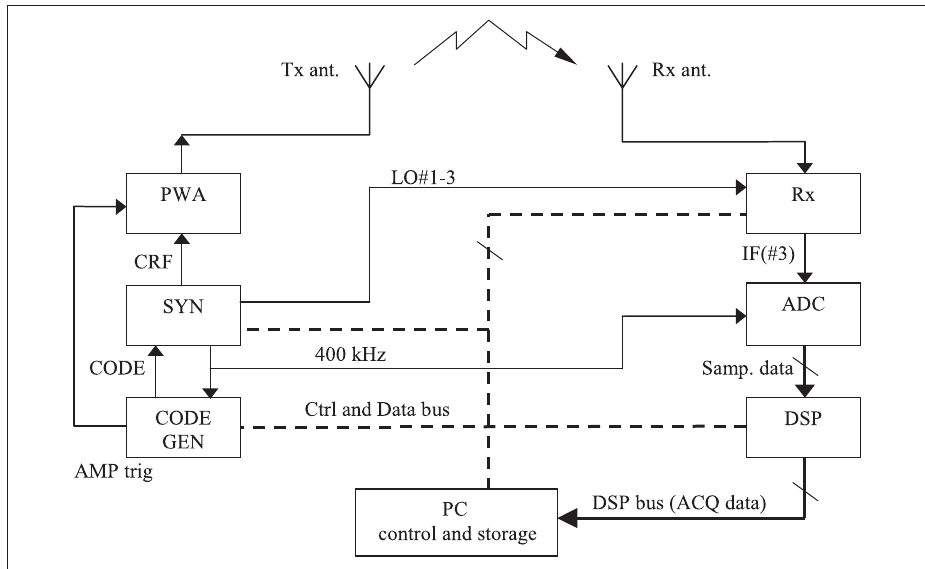
Fig. 1. Simplifi ed functional